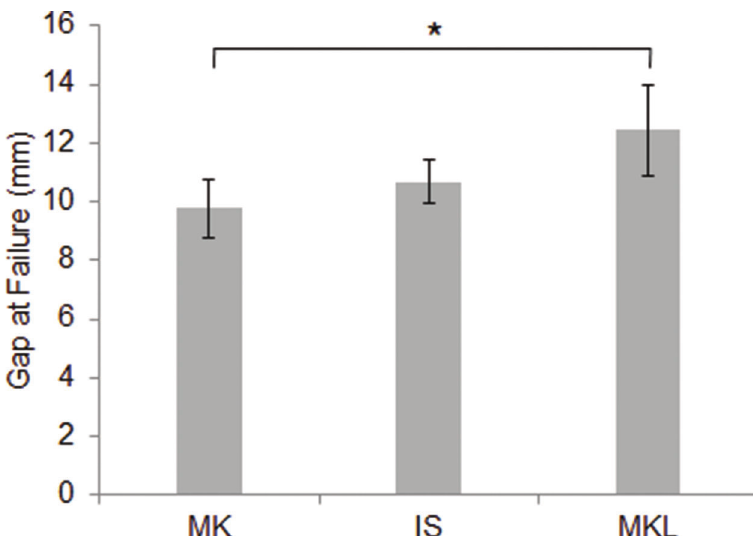
Figure 4 - Gaps at failure for different suture techniques. The largest gap at failure was seen in the MKL group (12.4 ± 1.5 mm), whereas gaps at failure were similar for the MK and IS techniques (9.8 ± 1.0 mm vs . 10.7 ± 0.7 mm, respectively). * p o 0.05 vs . MK.